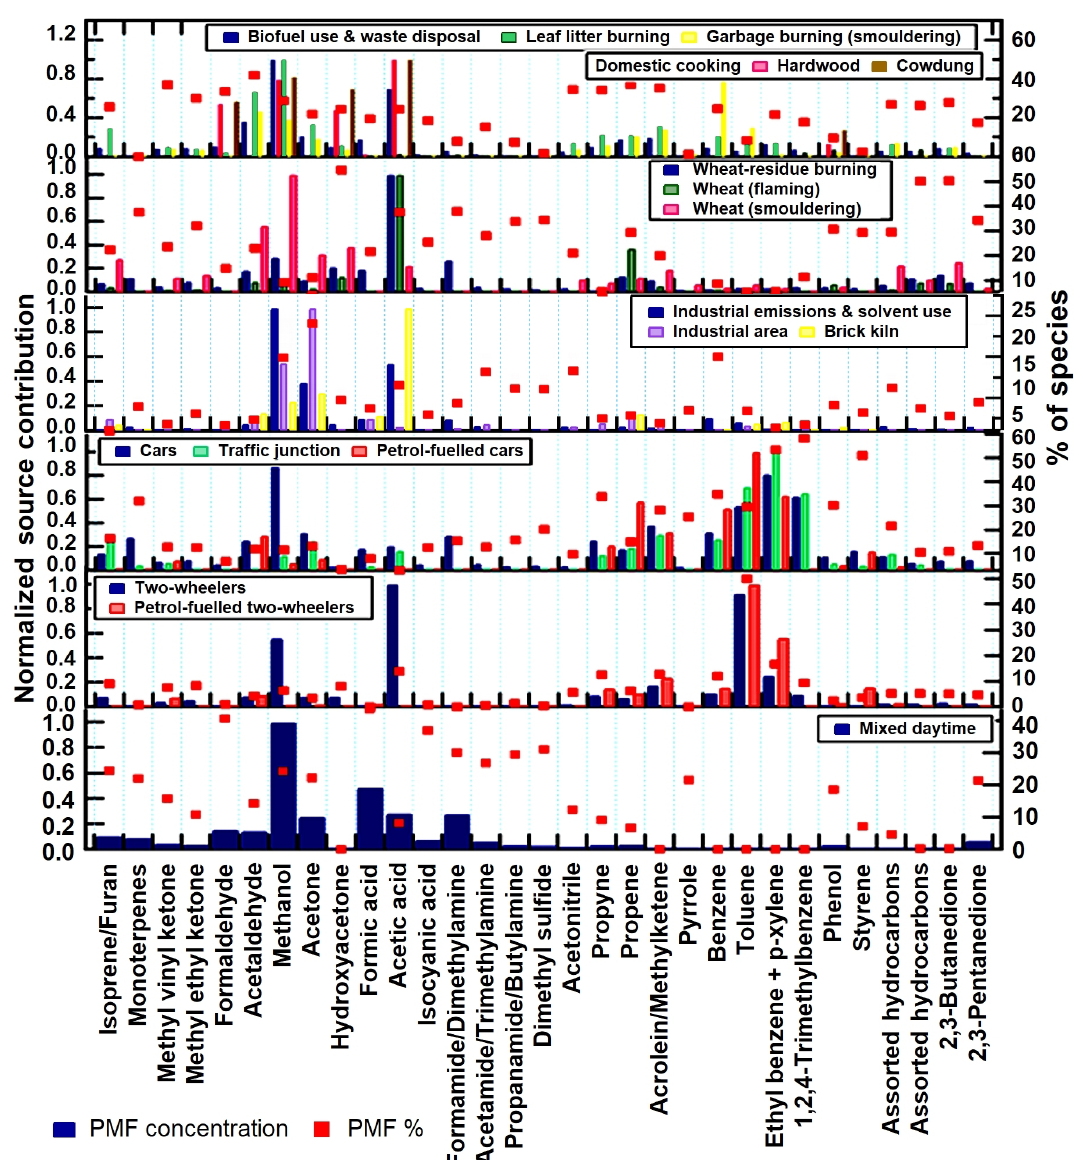
Figure 3. Factor profile composition for 6 PMF resolved factors at IISER-Mohali. It displays the normalized source fingerprints of the PMF factors (dark blue) and samples collected at the source (in various colors) in bar-chart form. The value of the normalized species contribution is depicted on the left-hand axis. The percentage of each species explained by each of the PMF factors is displayed in the form of a red square to be read from the right-hand